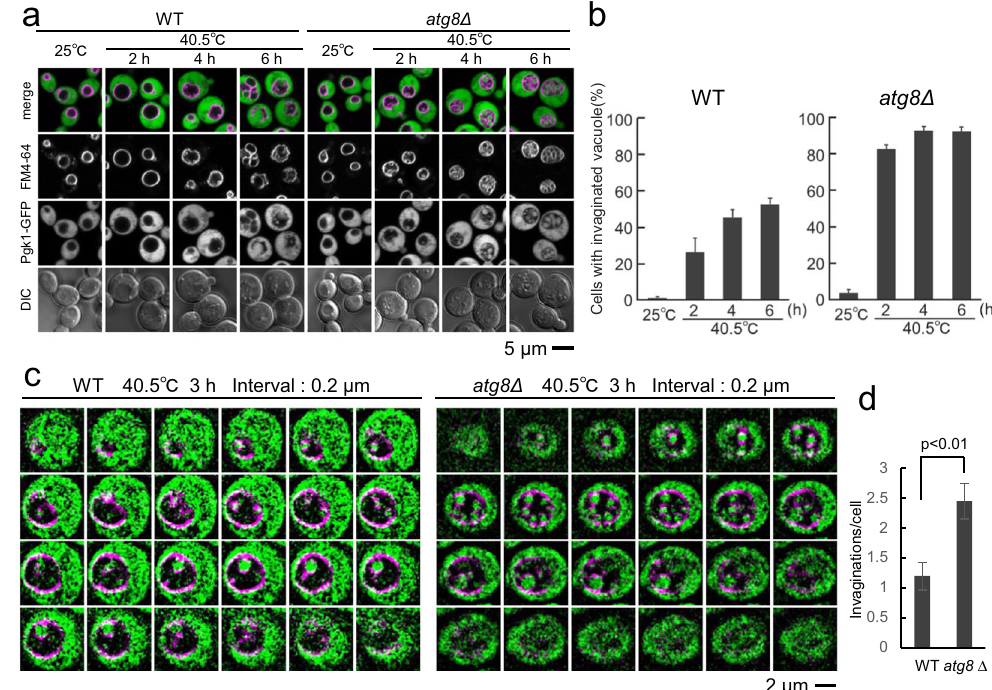
Figure 1. Greater acceleration of invaginations in the vacuolar membranes of atg8 Δ after chronic heat stress. ( a ) GFP and FM4-64 fluorescence of wild-type and atg8 Δ cells, expressing PGK1-GFP at 25 °C and 40.5 °C for 2, 4 and 6 h. Scale bar, 5 μ m. ( b ) Quantification of ( a ). Cells with invaginated vacuoles were counted. The mean values of the ratio and standard errors (SE) are shown. Statistical significance: p = 0.0045, 0.0013 and 0.0014 by both-sided t-test for all the pairs between wild-type and atg8 Δ cells at 2, 4 and 6 h, respectively. ( c ) Z-stack analysis of invaginated structures of vacuolar membranes of wild-type and atg8 Δ cells after 3 h at 40.5 °C. The images were taken by SCLIM. Scale bar, 2 μ m. ( d ) Quantification of number of invaginations per cell in ( c ). Invaginations were counted using the serial sections of vacuoles taken by SCLIM, and 20 cells were counted for each. The mean, SE and p-values for both-sided t-test are shown.